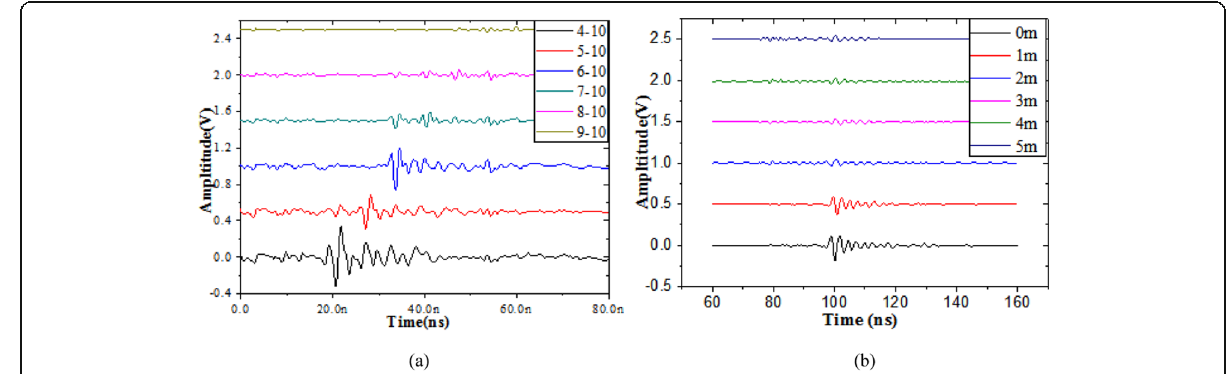
Fig. 10 Signals received by moving target. a Perpendicular to system moving target. b Parallel to system moving